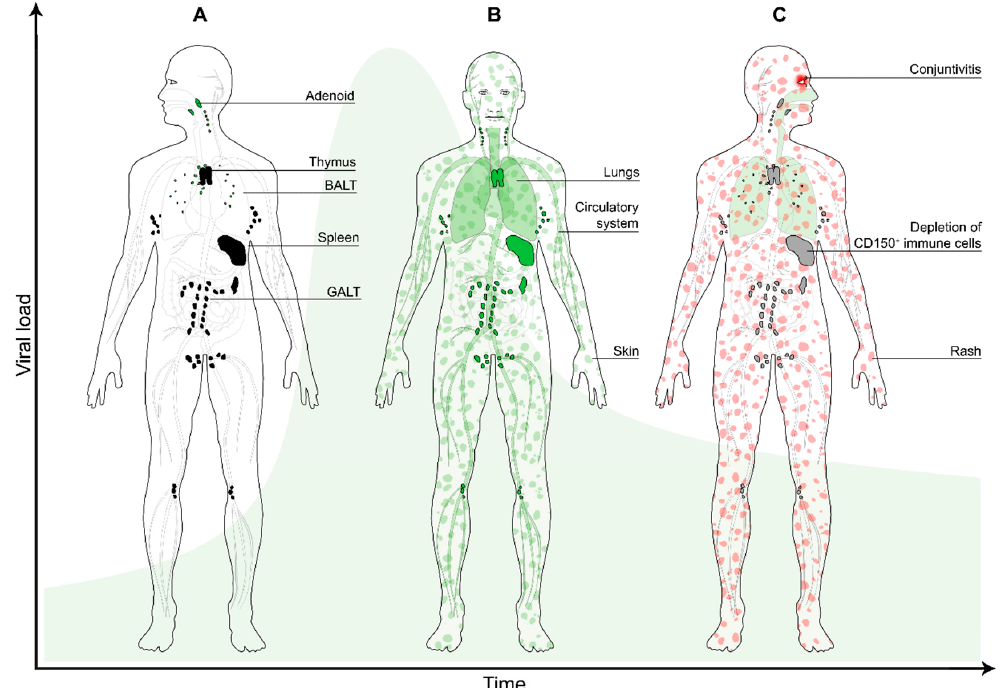
Figure 2. The second stage of MV infection: systemic dissemination. ( A ) The MV-infected myeloid cells migrate to the draining lymph nodes (black), where they transmit the virus to CD150 + lymphocytes (predominantly B-cells and memory CD4 + and CD8 + T-cells); ( B ) during viremia infected cells enter the circulation and migrate systemically to various organs and tissues (green), where the infection is further amplified. Infection of skin-resident immune cells results in virus transmission to nectin-4 + epithelial cells (green patches); ( C ) a few days later, depletion of immune cells in lymphoid organs and tissues results in transient immune suppression (grey). MV-specific T-cells infiltrate the skin where they clear the infected cells, which results in the typical measles skin rash (red patches). The green bell-shaped curve in the background represents the viral load over time.